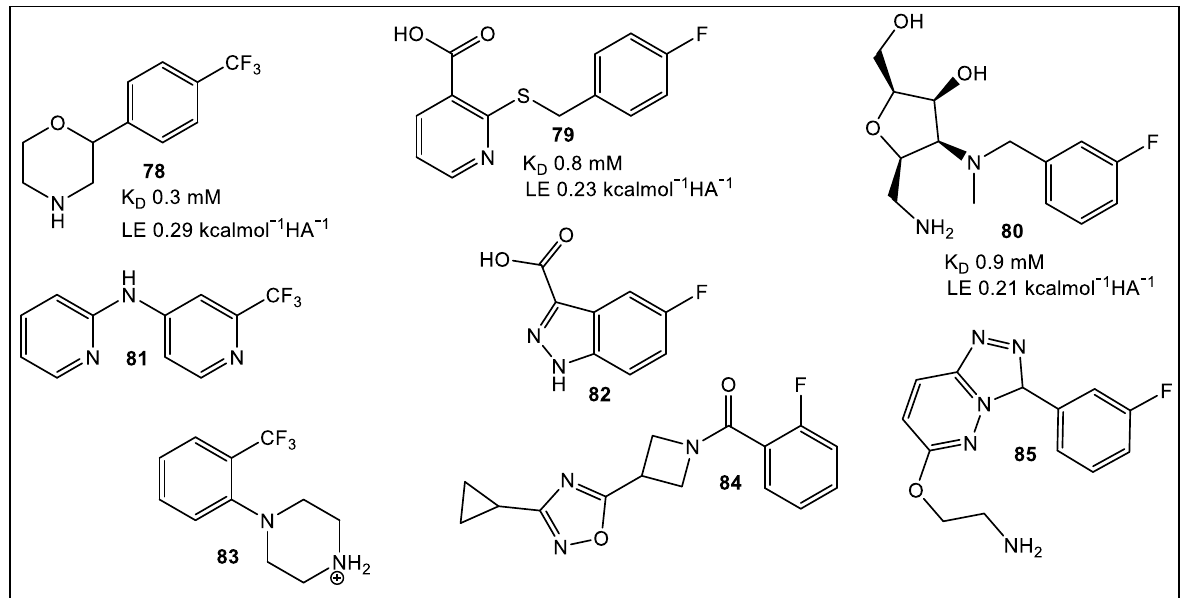
Figure 14. Structures of the best hits after 19 F NMR screening and validated by SPR with above aver- age of 9% in 1 H- 15 N TROSY NMR from set of 39 fragments. Fragments 78 , 79 , and 80 demonstrated binding to the secondary binding sites of BambL. The SAR of 78 demonstrated binding pocket identity predicted by computational study of fragment 78 scaffold that is responsible for the binding